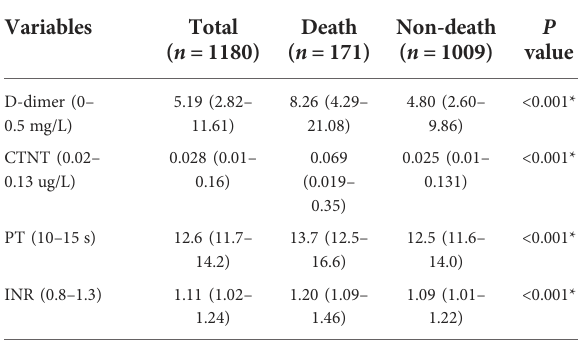
TABLE 2 Laboratory test results of non-death and death AAD